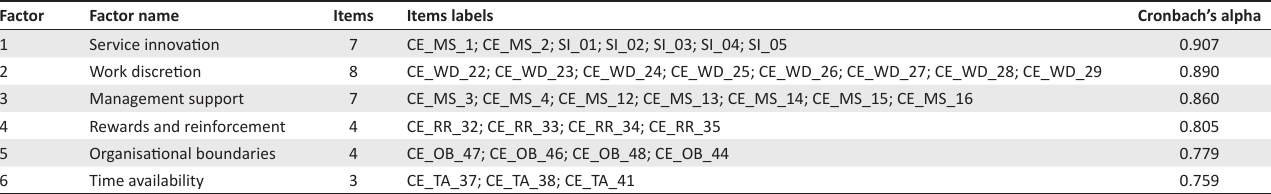
Rewards and reinforcement